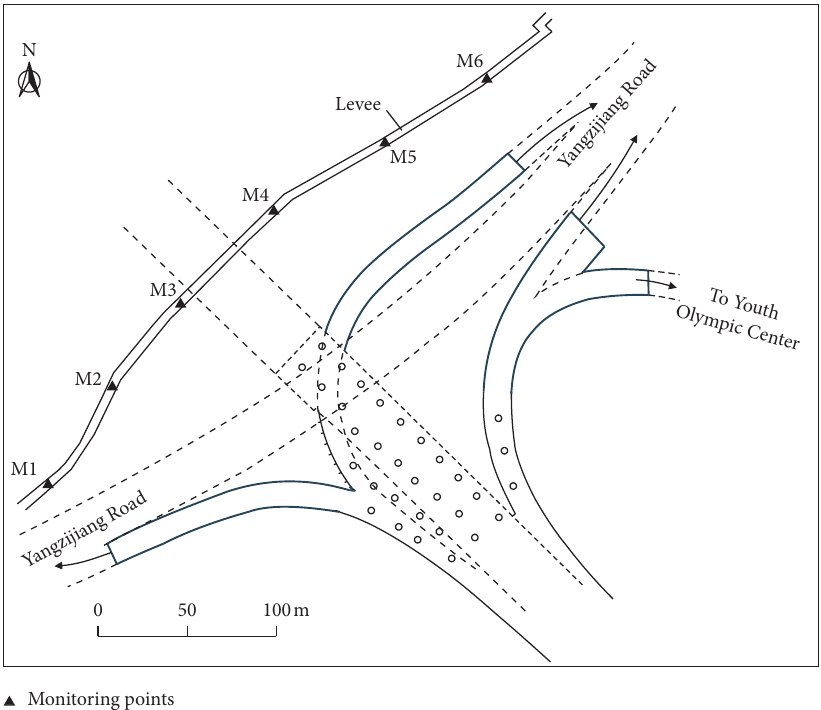
Figure 4: Layout of the drainage wells.